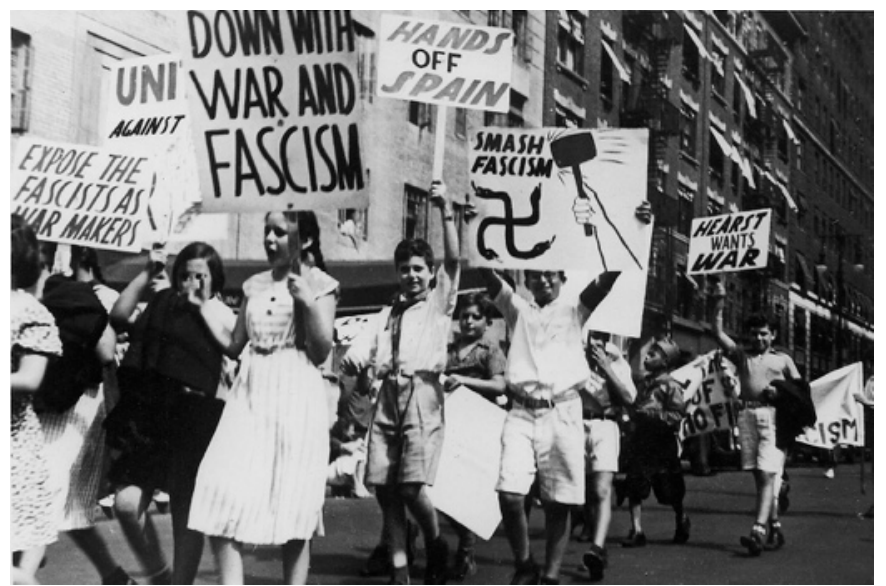
Figure 3. Leo Seltzer, ‘Anti-War and Anti-Fascist Demonstration, New York City’, 1933, gelatin silver print. © Leo Seltzer.